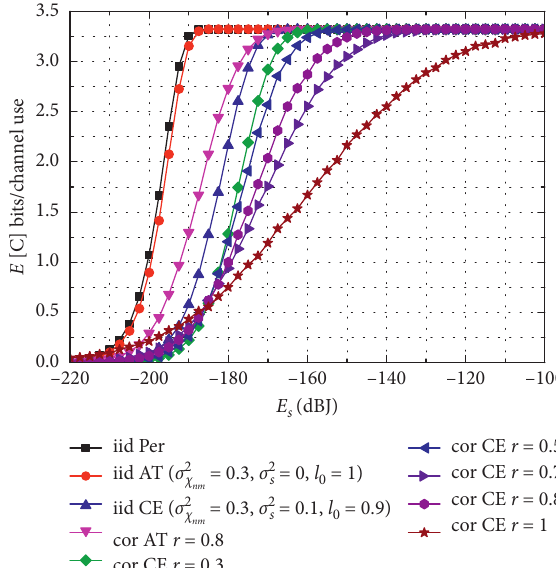
Figure 10: Ergodic channel capacity under combined effects over correlated channel for different correlation